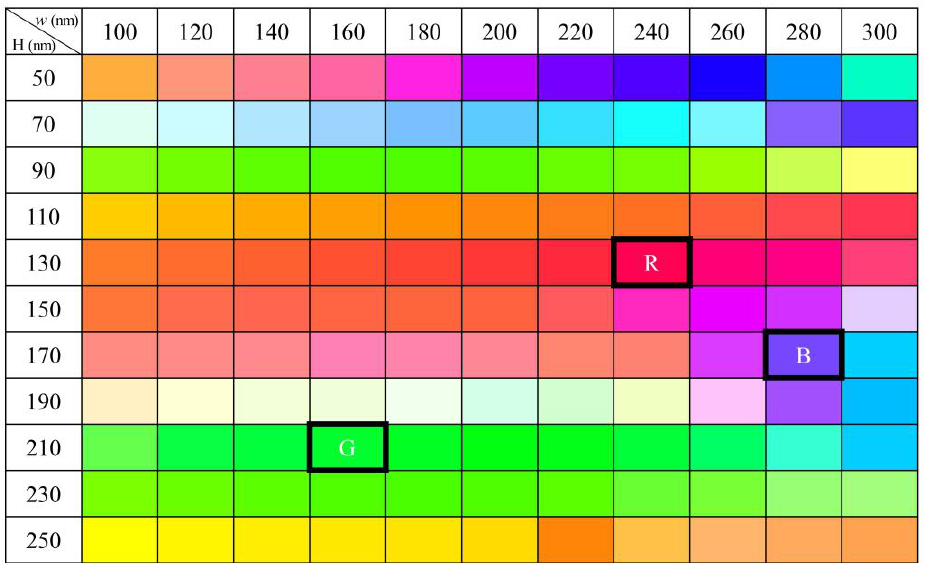
Figure 3. Color table of all cases simulated using the finite-difference time-domain (FDTD) method. The width ( W ) and height ( H ) of silver blocks range from 100 to 300 nm and from 50 to 250 nm, respectively. Three black outlined boxes indicate three representative structures and the corresponding colors, red (R), green (G), and blue (B).